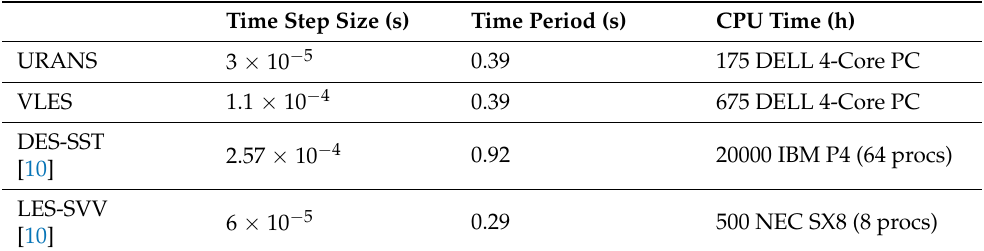
Table 4. Comparison of CPU Times of URANS, VLES, DES and LES.